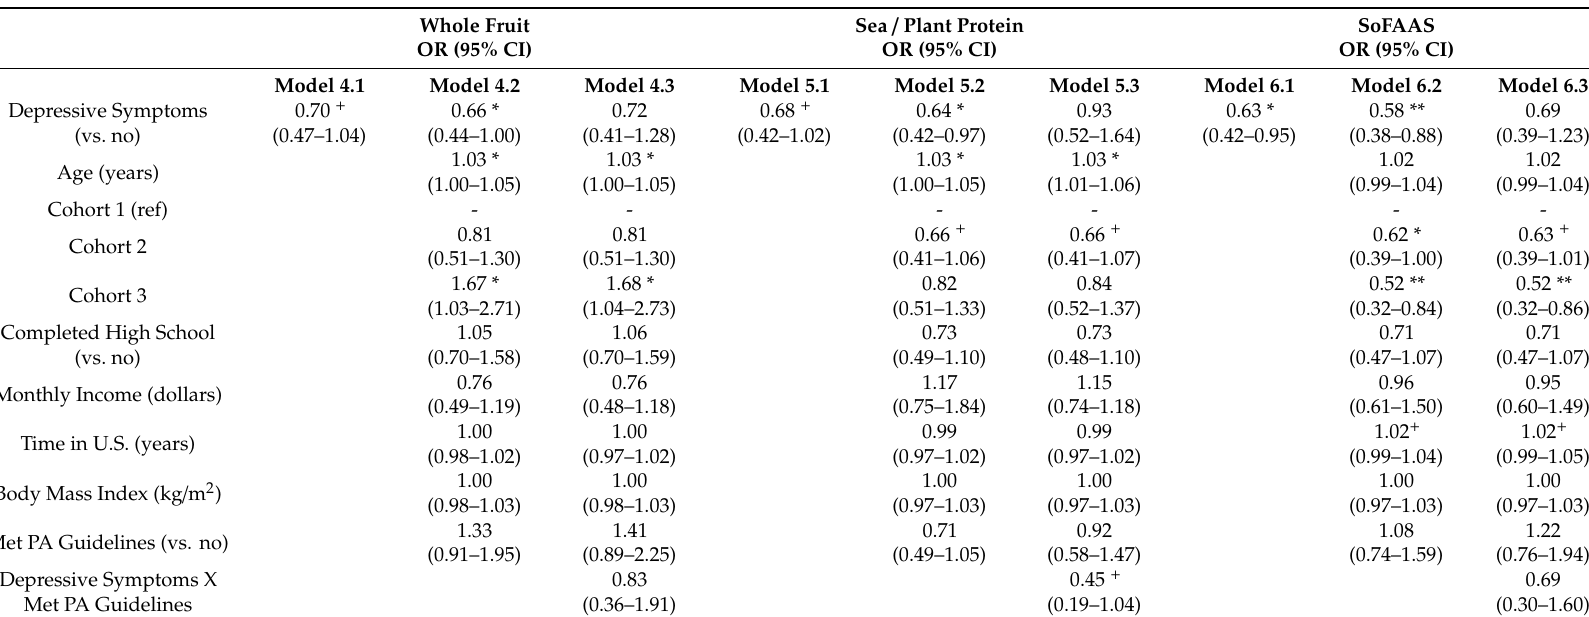
Table 3. Logistic regression models associating higher HEI whole fruit, sea / plant protein, and SoFAAS component scores, with depressive symptoms, physical activity, and two-way interaction between depression and physical activity; Enlace (2012–2016; n =